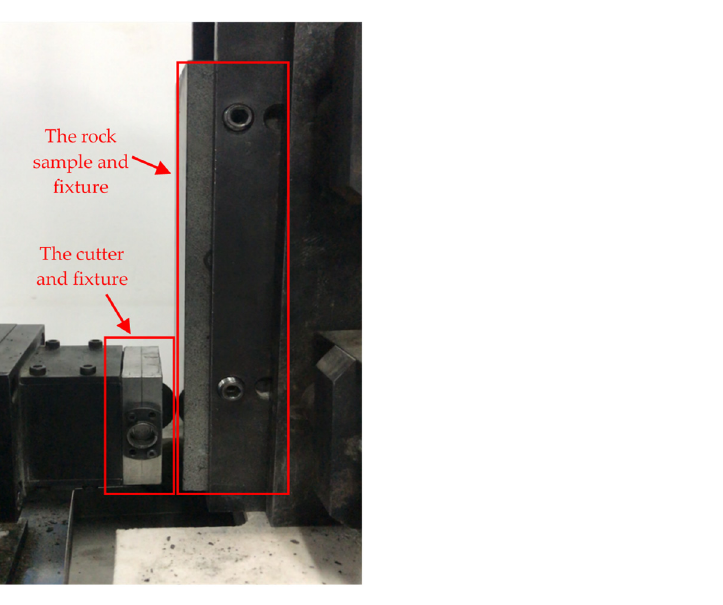
Figure 4. Installation of the reduced-scale TBM cu tt er and the fi xture: ( a ) Reduced-scale TBM cu tt er;